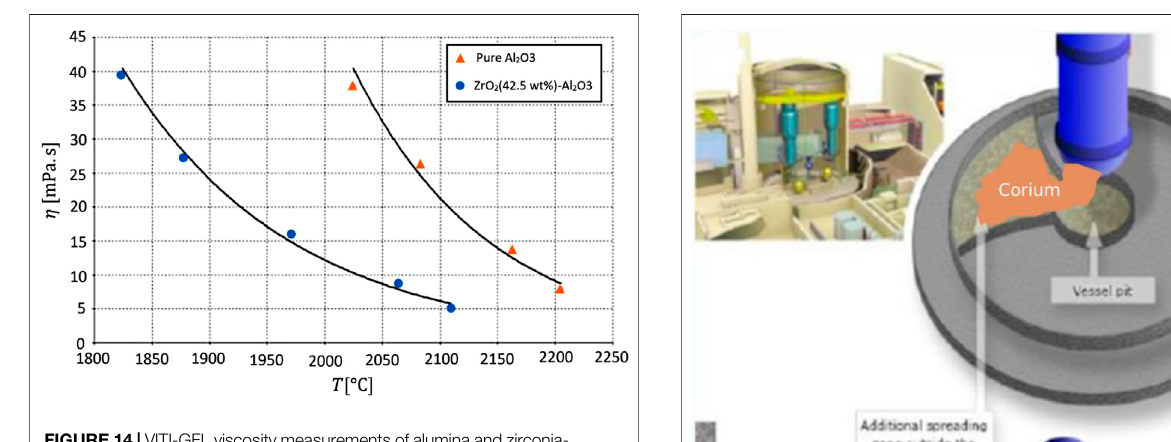
FIGURE 14 | VITI-GFL viscosity measurements of alumina and zirconia- alumina eutectic, from Grishchenko and Piluso (2011).